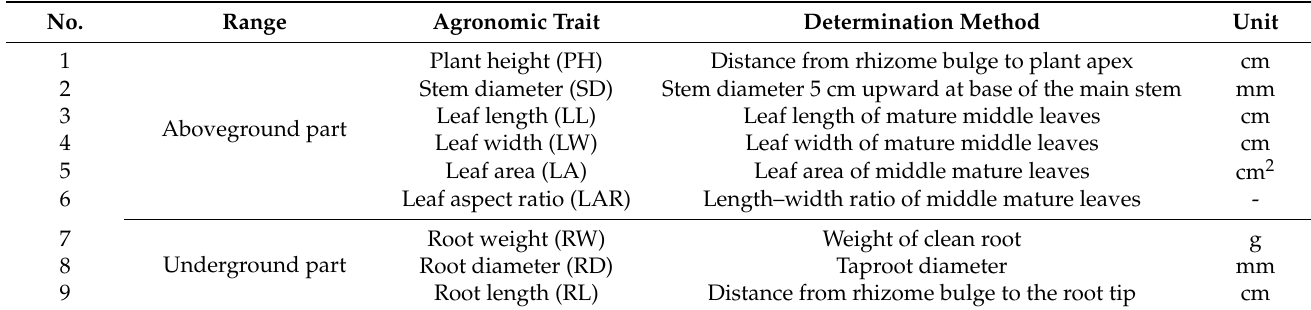
Table 2. Determination indexes of agronomic traits of Radix bupleuri